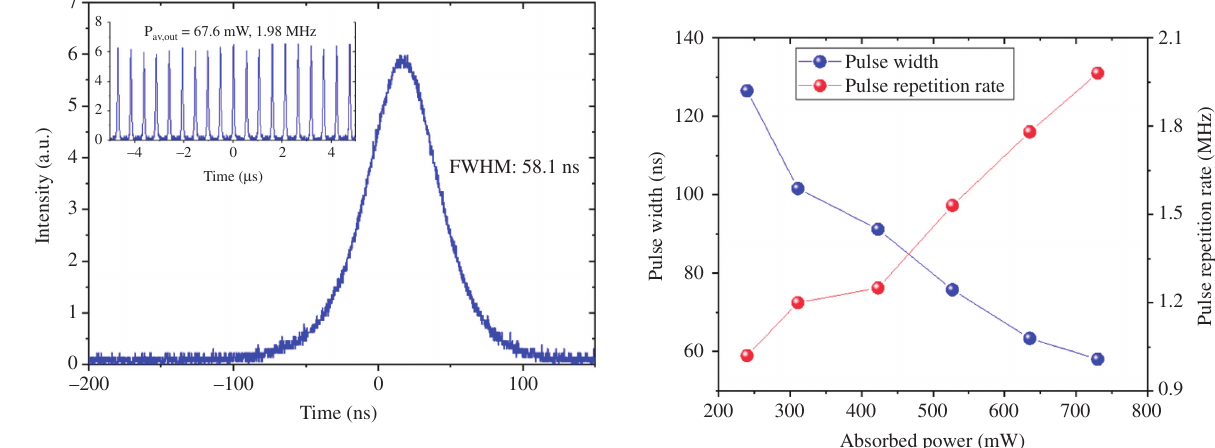
Figure 8: The pulse width and pulse repetition rate varying with absorbed